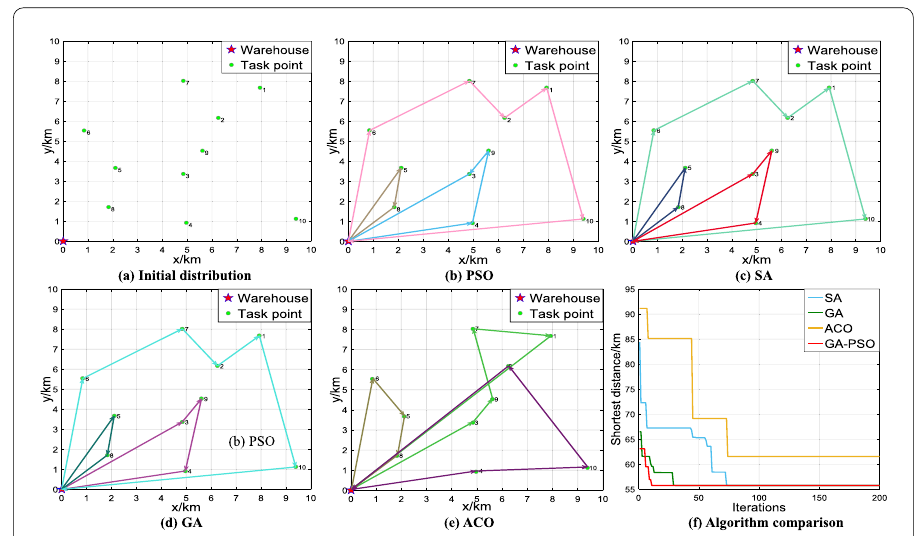
Fig. 5 The results of the first group of the experimental optimal solutions of task allocation